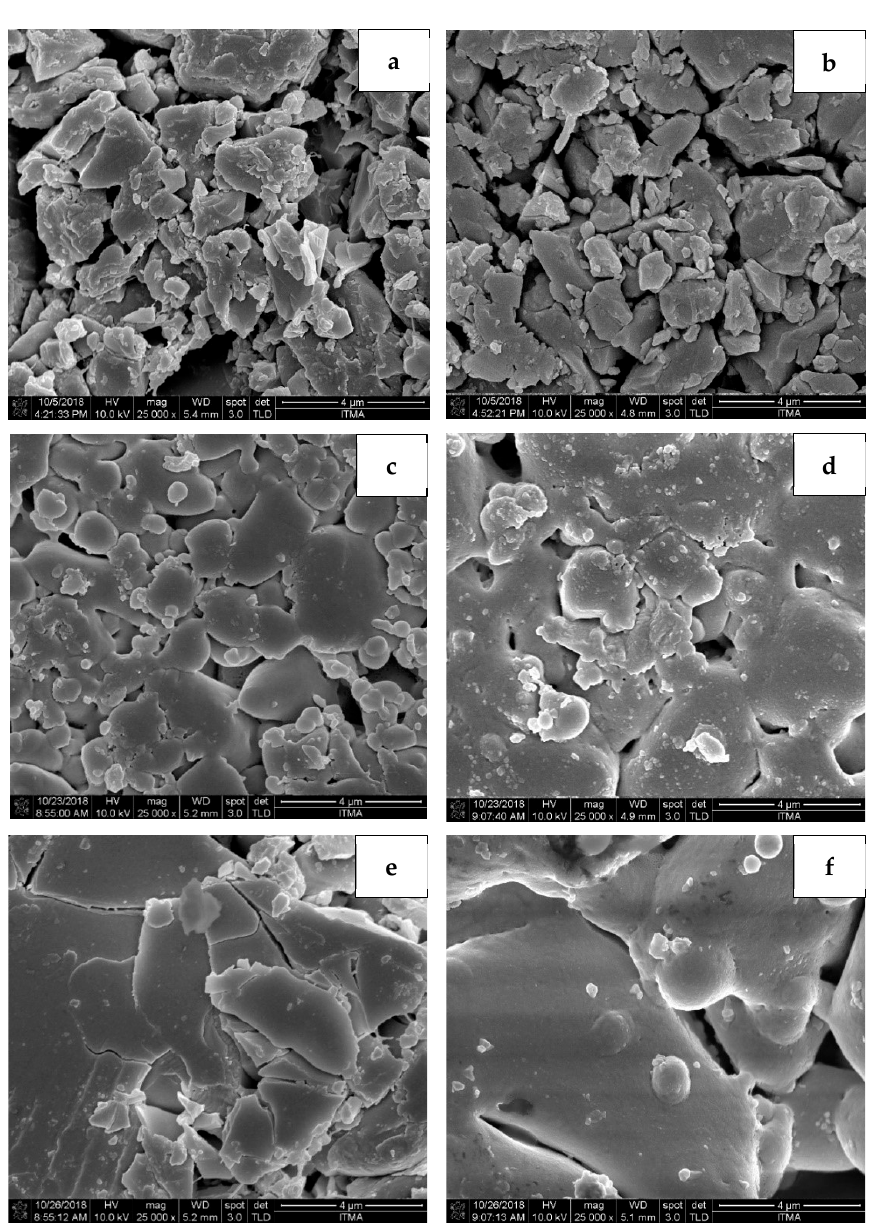
Figure 6. The microstructure images of zinc silicate sintered at different sintering temperature of